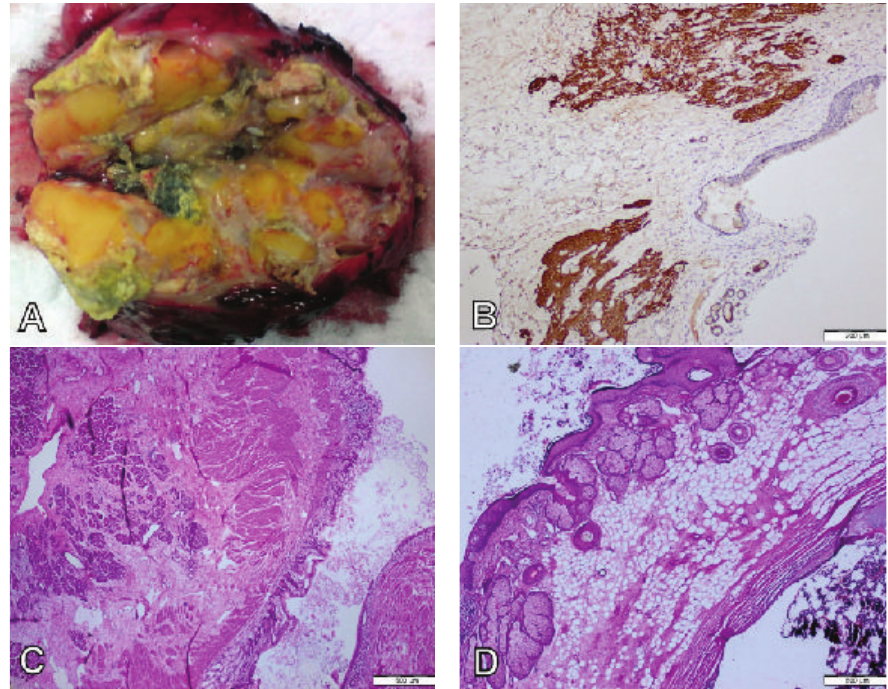
Figure 2: (A) Cystic spaces, fat, cartilage, and hair can be seen in surgical resection material. (B) Glial tissue was stained with GFAP in immunohistochemical study ( × 40). (C) Muscle, connective tissue, columnar epithelium, and pancreatic tissue were seen by microscopy (HE, × 40). (D) Epidermis, skin appendages, fat tissue, and bone tissue areas were seen on microscopic study (HE, ×